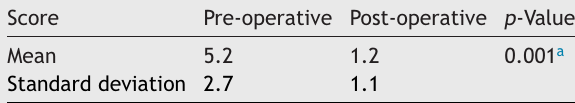
Comparison of Lund---McKay tomographic score between pre-operative and